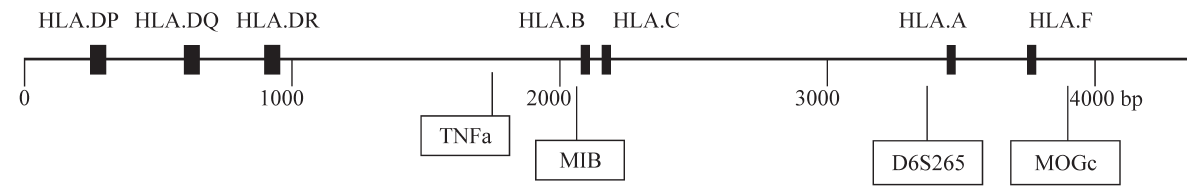
Figure 1 - Schematic representation of the major histocompatibility gene complex and positions of microsatellites. Dejean et al .